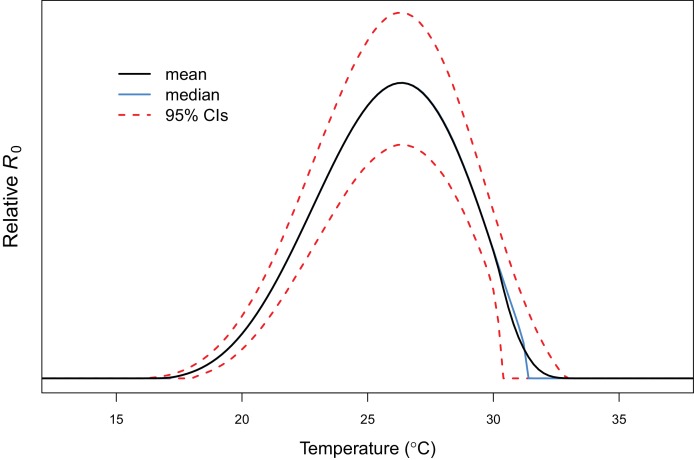
Example comparison of mean and median R0 results.